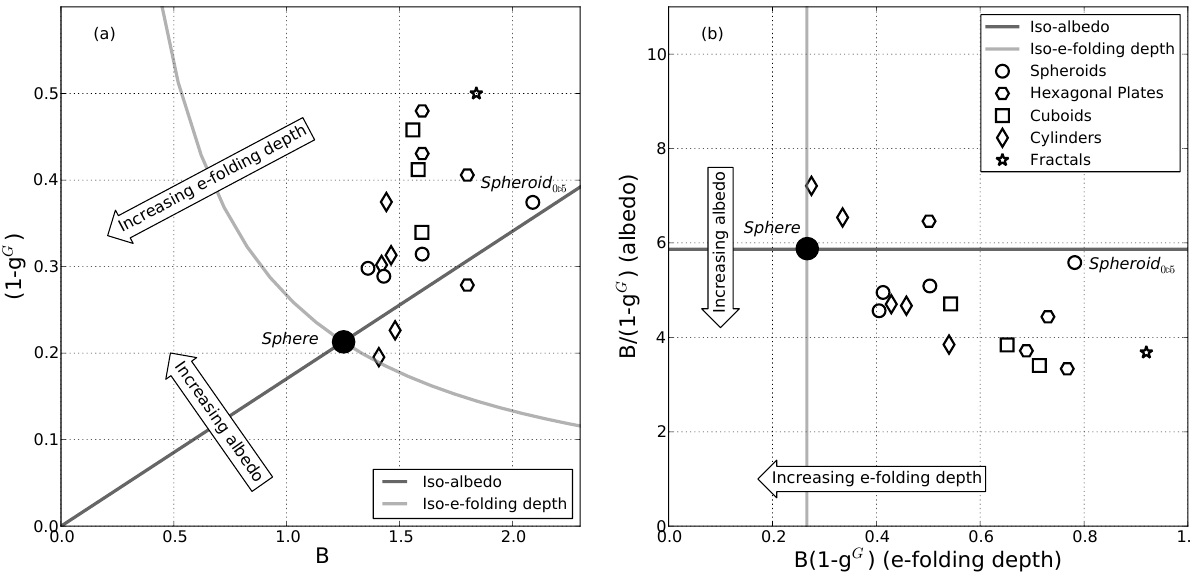
Fig. 1. (a) The shapes presented in Table 1 are displayed in a B , ( 1 − g G ) diagram. (b) The same shapes are presented in a B( 1 − g G ) , B/( 1 − g G ) diagram, to illustrate their characteristics in terms of e -folding depth and albedo (see Eqs. 10 and 11).